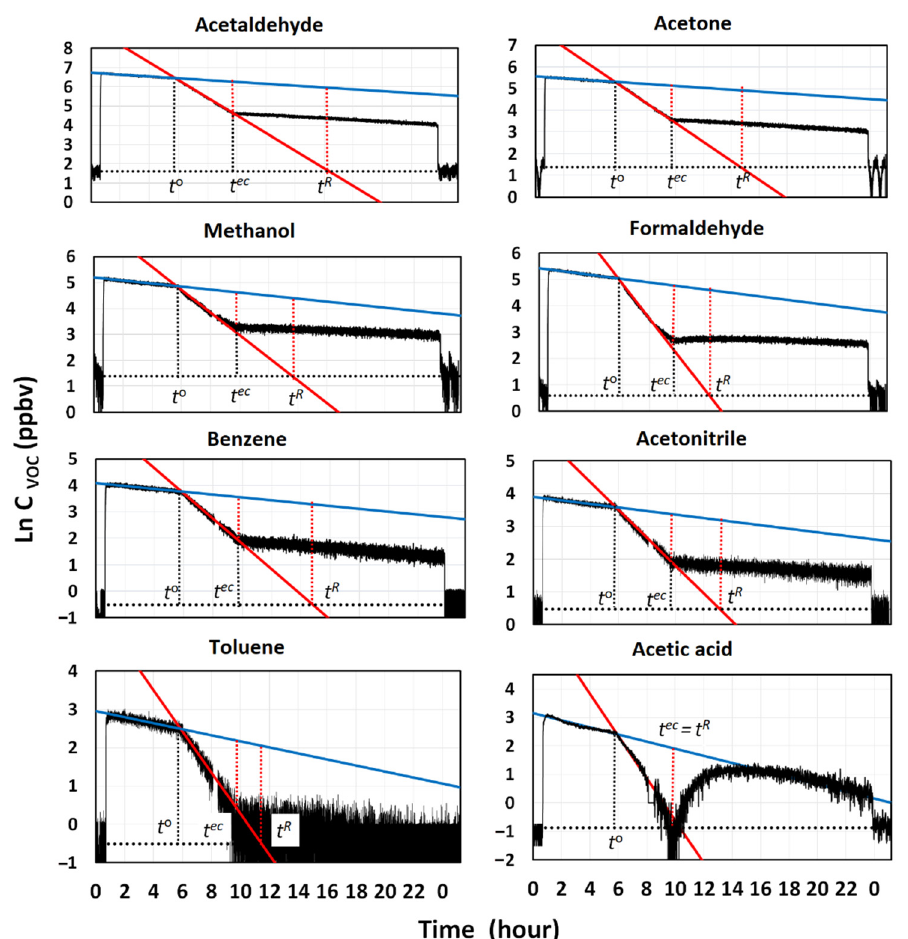
Figure 3. Semi-logarithmic plots of the mixing ratios of selected VOCs vs. time recorded in the testing room in the experiments performed with diesel exhaust emission, using the GIOEL air cleaner run at the minimum speed. The meaning of the lines and of the symbols are the same as in Figure 2. Vertical dotted segment in black = net amount of VOC to remove, and vertical dotted segment in red = net amount removed by the cleaner. The time t ed = ending time of cleaning.